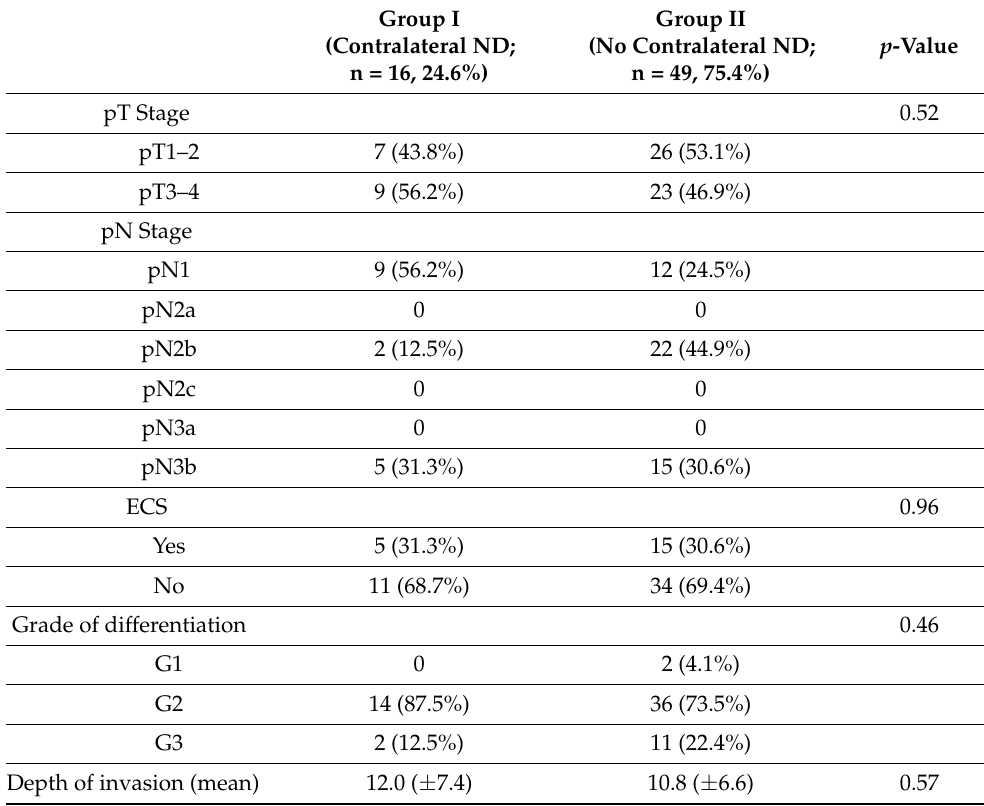
Table 2. Histopathological